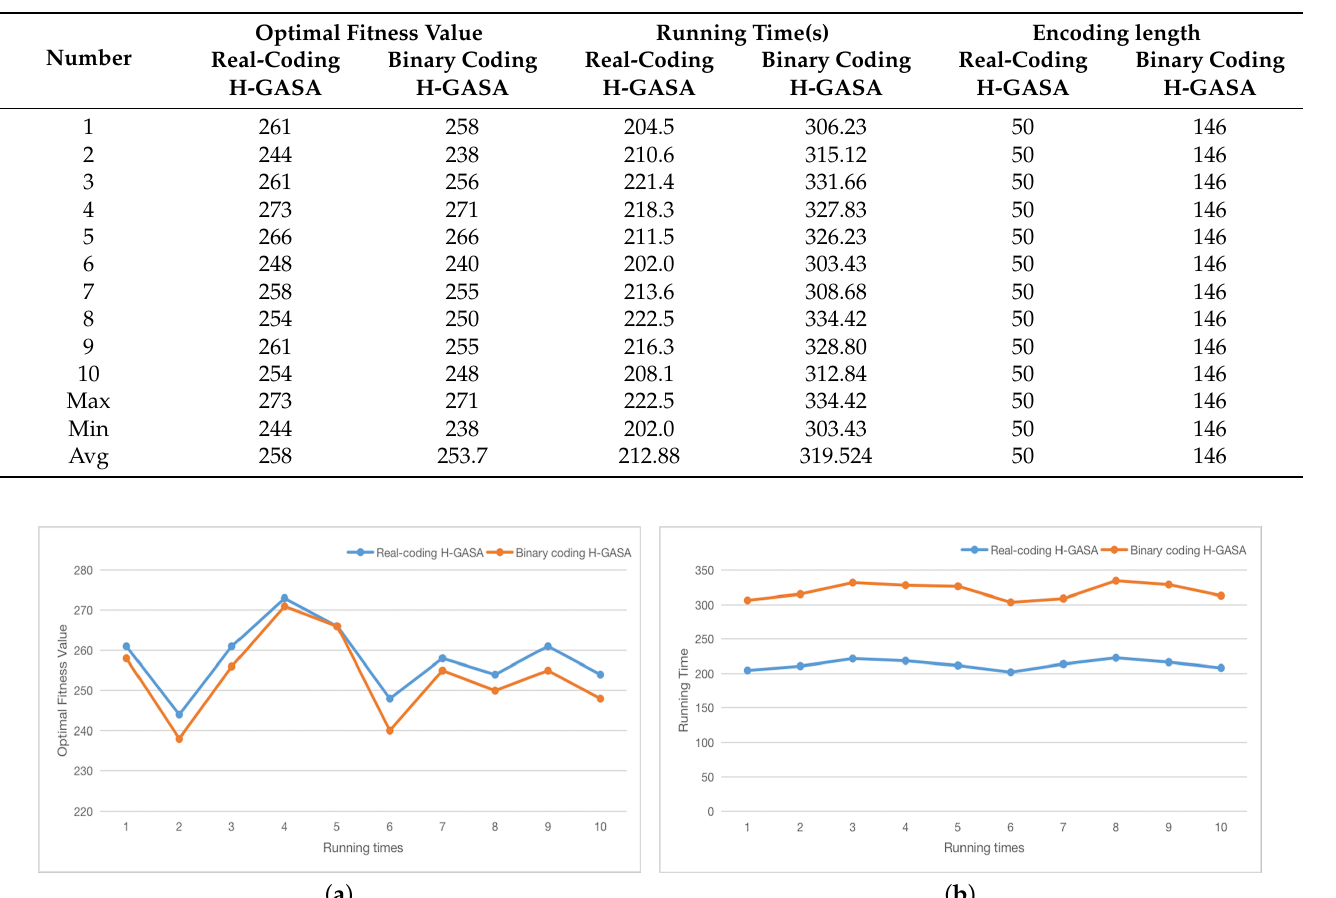
Table 4. Statistical results of different coding format in H-GASA.